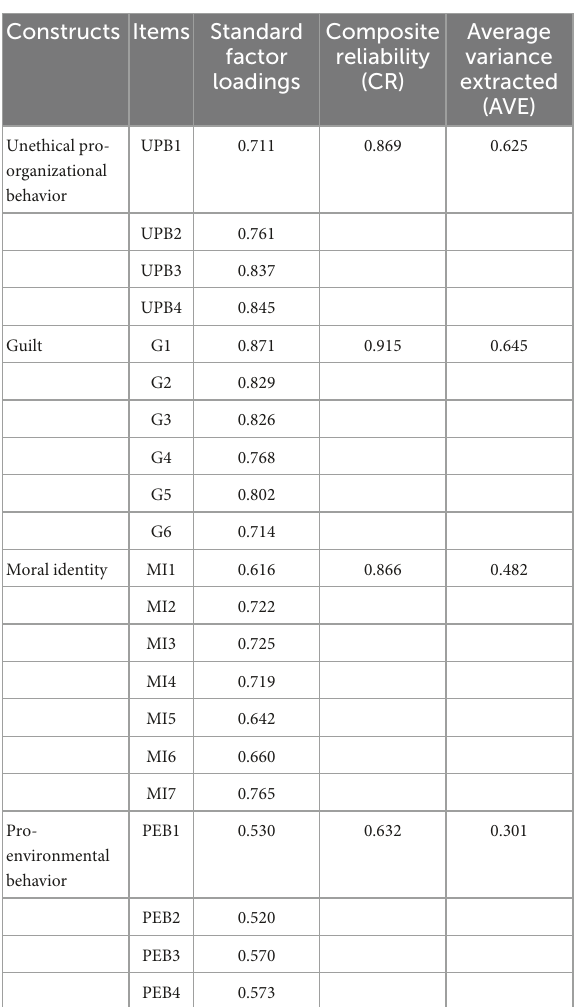
TABLE 2 Measurement validity